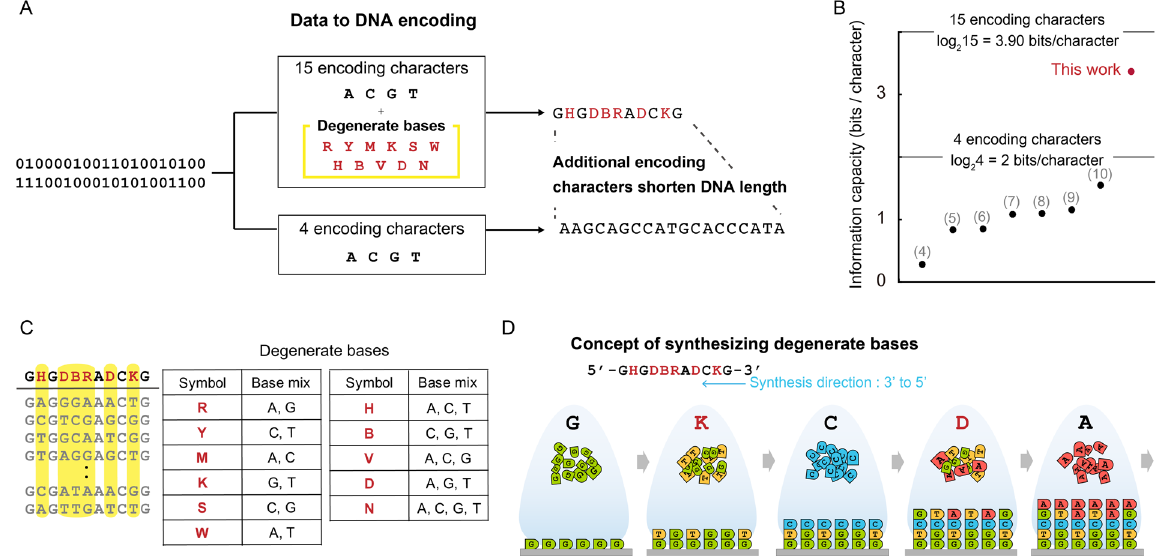
Figure 1. DNA-based data storage with addition of degenerate bases enables increased information capacity. ( A ) Binary data is encoded to DNA sequences comprising not only the 4 traditional encoding characters A, C, G, and T but also 11 additional degenerate bases. The length of encoded DNA is less than that of the four- character encoding method. ( B ) The theoretical information capacity limit is therefore increased from 2